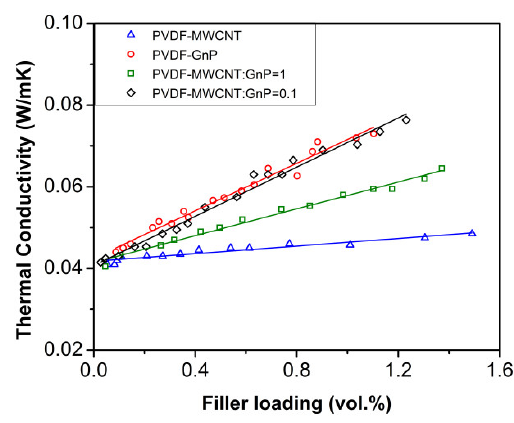
Figure 4. Thermal conductivities of PVDF nanocomposites as a function of filler loadings.